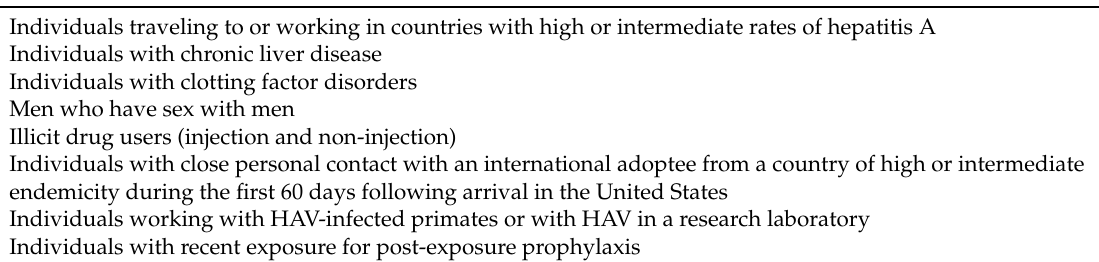
Table 1. Recommendations for adult vaccination